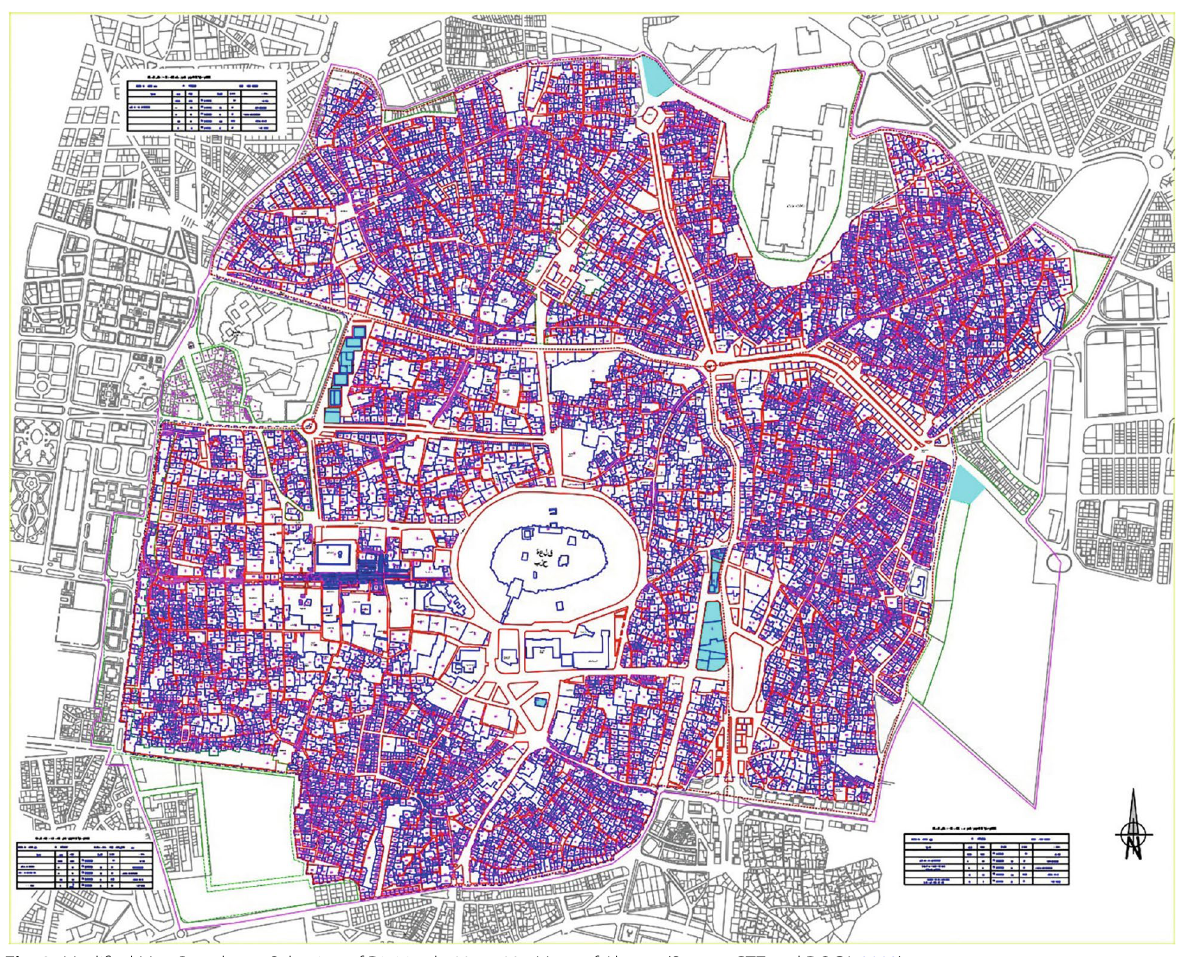
Fig. 3 Modified Map Based on a Selection of Digitised 1927–1931 Maps of Aleppo (Source: GTZ and DOCA